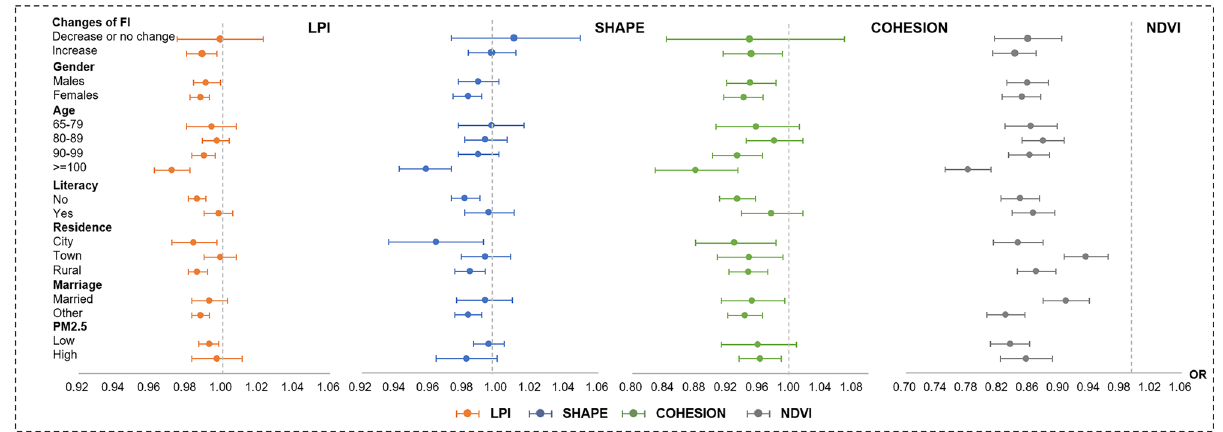
Fig. 2 Subgroup analysis of the ORs (estimates with 95% CIs) of frailty indices of greenspace structures and NDVI according to changes of FI ( N = 2855), sex, age, literacy, urban or rural residential location, marital status, and PM 2.5 ( N = 8776). Adjusted for age, sex, the study entrant year, marital status, geographic region, urban or rural residential location, literacy, annual household income, fi nancial independence, BMI, smoking status, alcohol consumption, exercise status, three-year average, PM2.5. LPI: largest patch index. Shape: shape index. Cohesion: patch cohesion index. NDVI: normalized difference vegetation index. CI: con fi dence interval. OR: odds